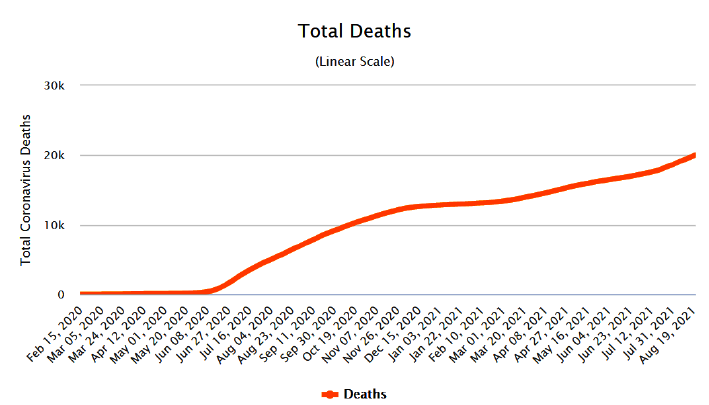
Figure 2. The total deaths of COVID-19 in Iraq (Worldometer,